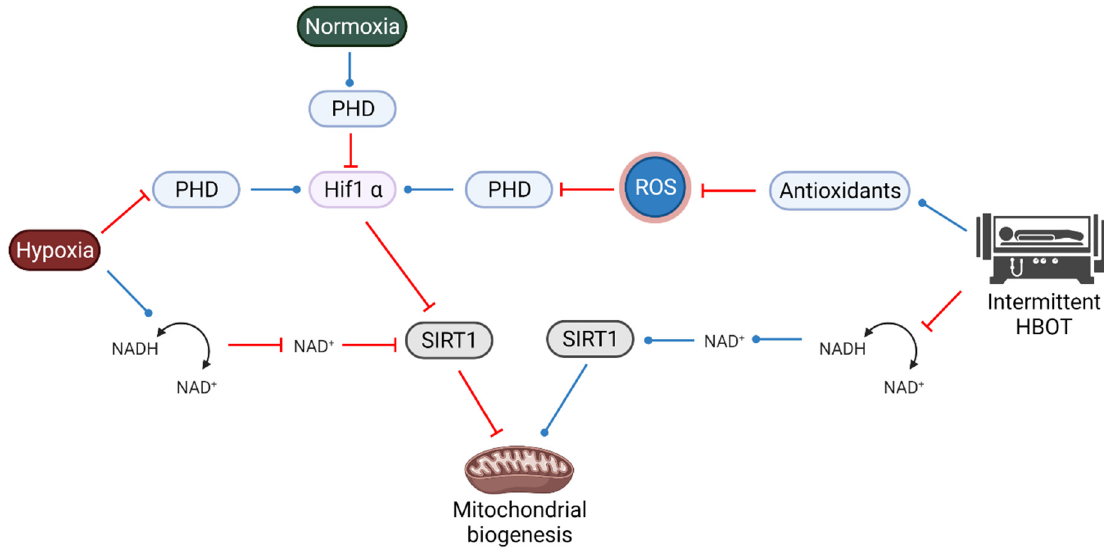
Figure 4. Interplay between SIRT1, HIF1a and ROS during HBOT. Under normoxia, PHD senses oxygen and leads to the degradation of HIF1a. Hypoxia inhibits PHD, leading to an increase in HIF1a, while intermittent HBOT elevates antioxidants, which leads to inhibition of PHD, therefore mimicking a hypoxic state and also activating HIF1a. In a parallel by interwind pathway, hypoxia causes inhibition of SIRT1 via changes in NADH/NAD + ratio that can lead to inhibition of mitochondrial biogenesis, while intermittent HBOT activates SIRT1, leading to an activation of mitochondrial biogenesis.